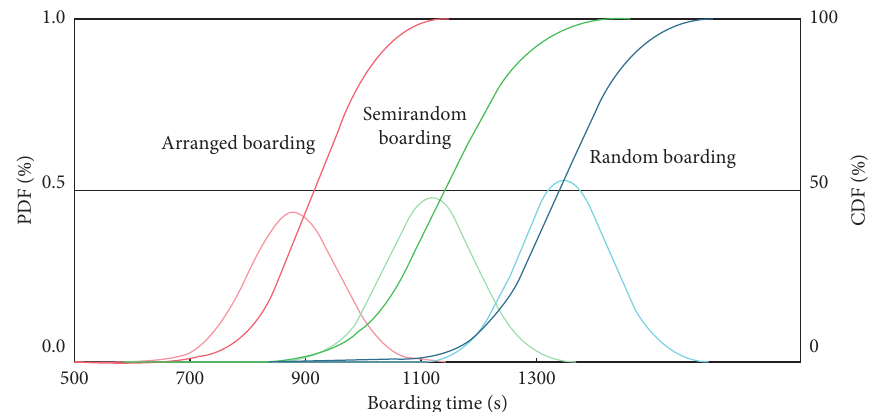
Figure 5: Probability function and distribution of boarding time in different strategies.